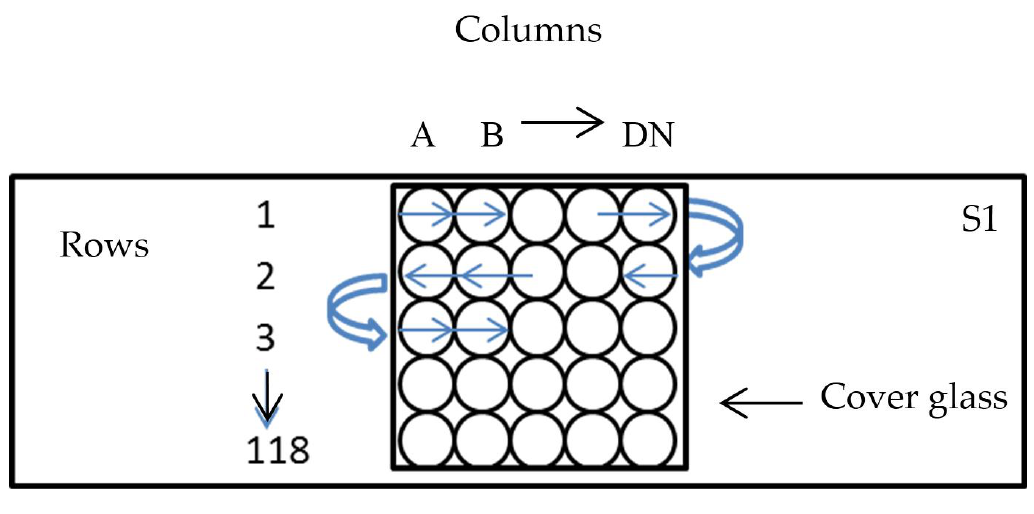
Figure 1. Virtual count matrix (represented by columns A, B, C…DN and rows 1, 2, 3…118) including 13,924 fields of view (depicted by circles) on the cover slip (area counted = 4.316 cm 2 ) of sample S1. Direction of counting is shown by the blue-coloured arrows. Black arrows indicate column and row enumeration direction and the position of the cover glass on the microscope slide.